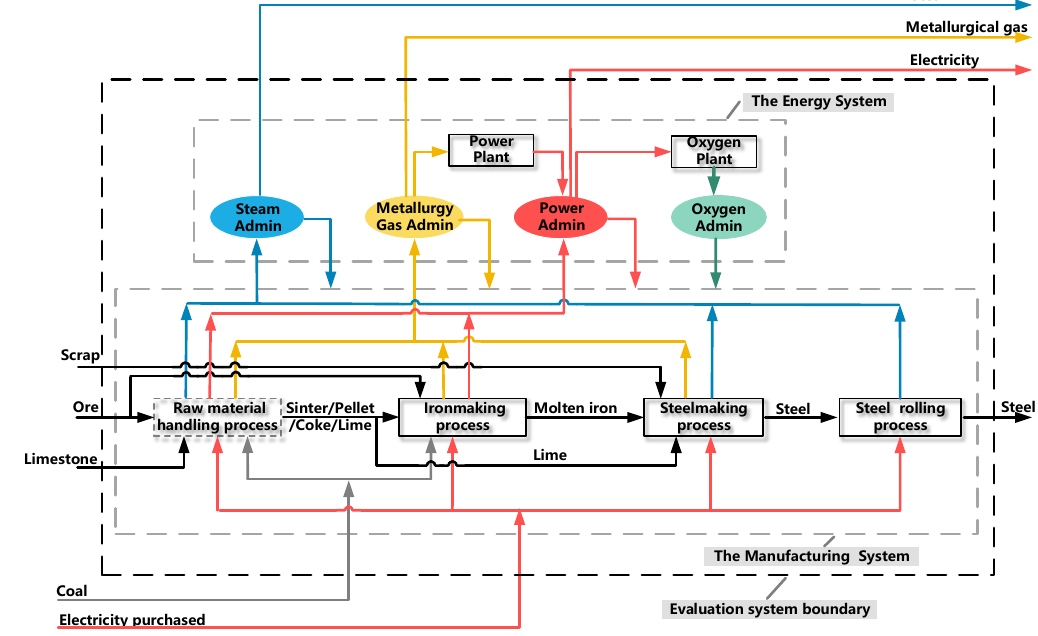
Figure 3. The integrated steel plant (ISP) in this study.